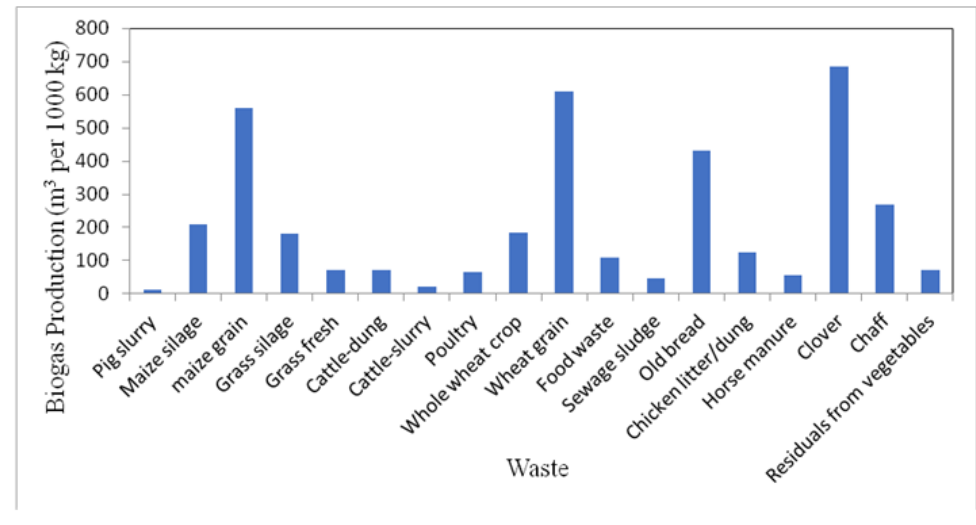
Figure 12. Biogas production amount based on the use of different wastes.